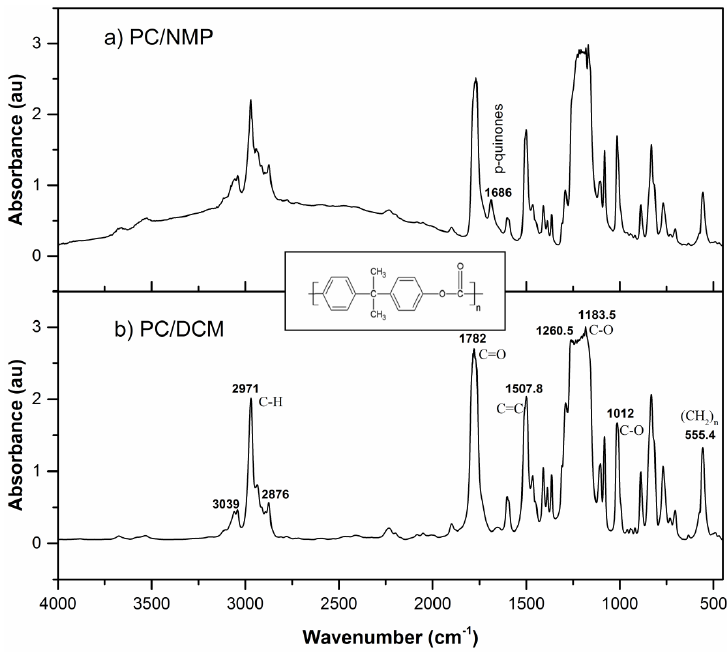
Figure 8. FTIR Absorption spectra for PC membranes prepared by ( a ) 18 wt % PC/NMP and (b ) 18 wt % PC/DCM.